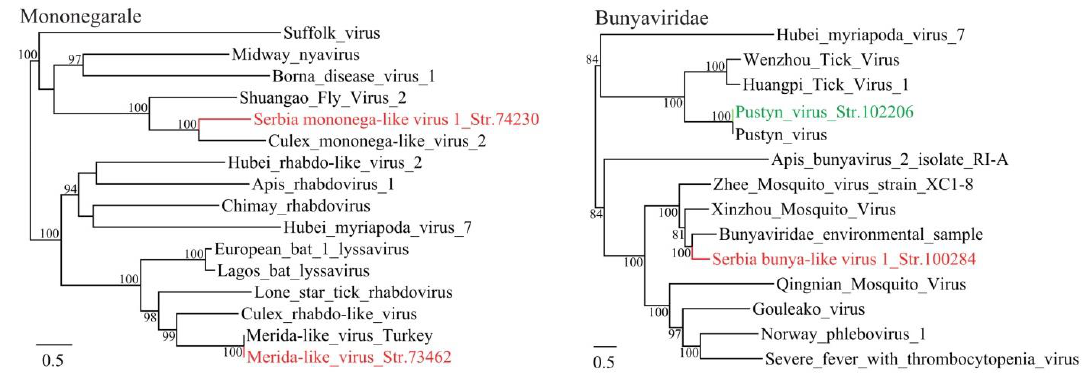
Figure 1. Phylogenetic analysis of -ssRNA viruses including Mononegarales and Bunyavirales. Phylogenetic trees were inferred using the ML method, with 1000 bootstrap replicates and mid-point